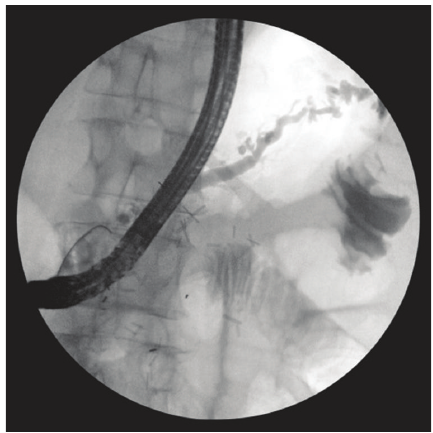
Figure 6: Pancreatogram demonstrating pancreatic colonic fistula.